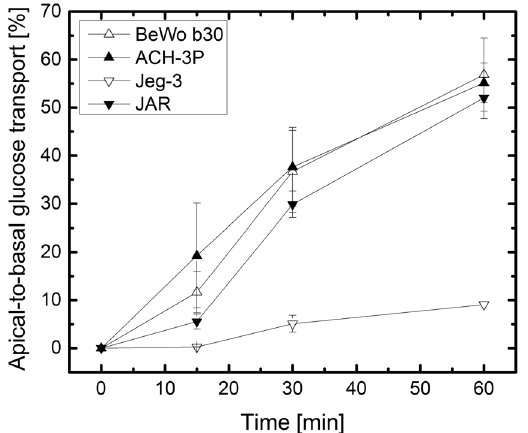
Figure 3. Influence of cell line type on transcellular transport of glucose. Apical-to-basal transport of 25 mM glucose through BeWo, ACH-3P, Jeg-3 and JAR cell barriers at day 5 post-seeding in transwell culture. Data points are presented as mean values ± SD for n = 3 and expressed as % of acellular controls (bare membrane inserts).